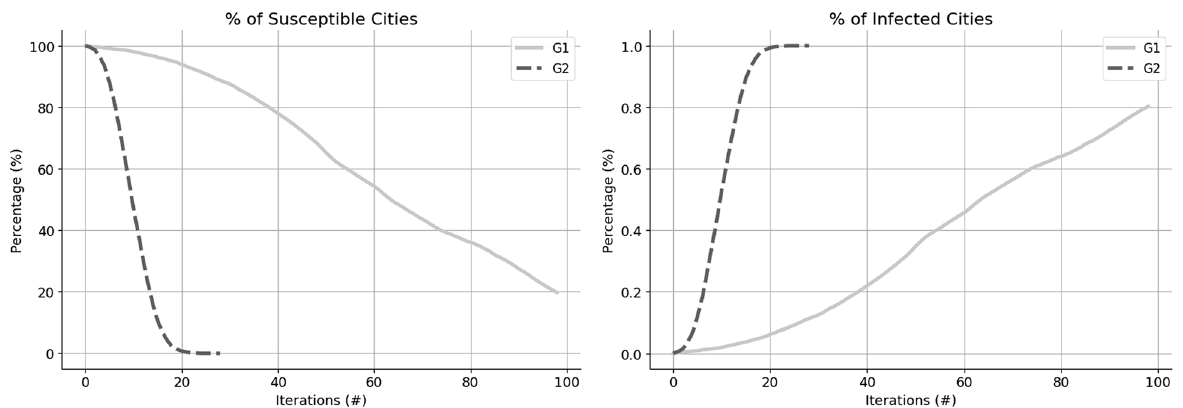
Figure 2. Epidemic simulations